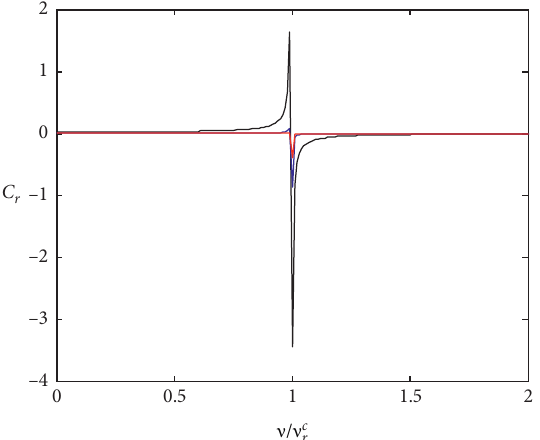
Figure 4: The change curve of first 3 orders of related time function amplitude C r with liquid velocity